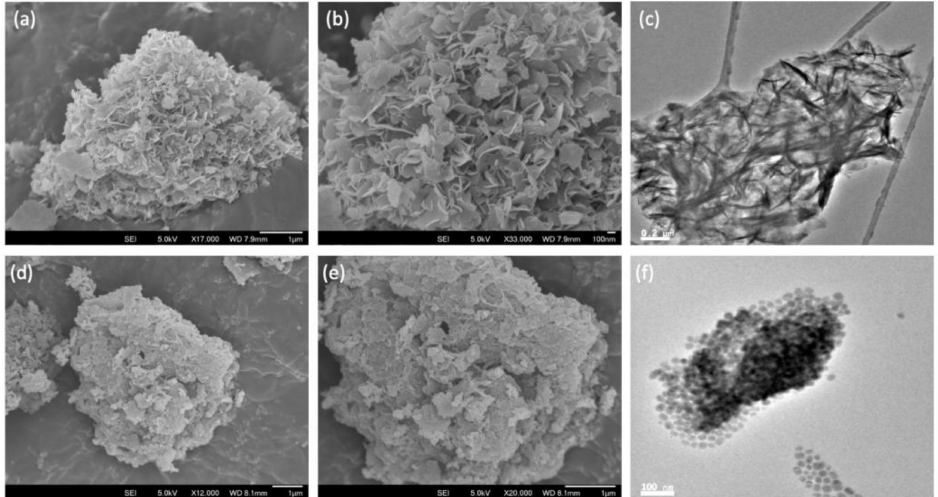
Figure 2. SEM and TEM images of SiO 2 -MgO catalysts prepared by the ( a – c ) ammonia evaporation and ( d – f ) wet-kneading